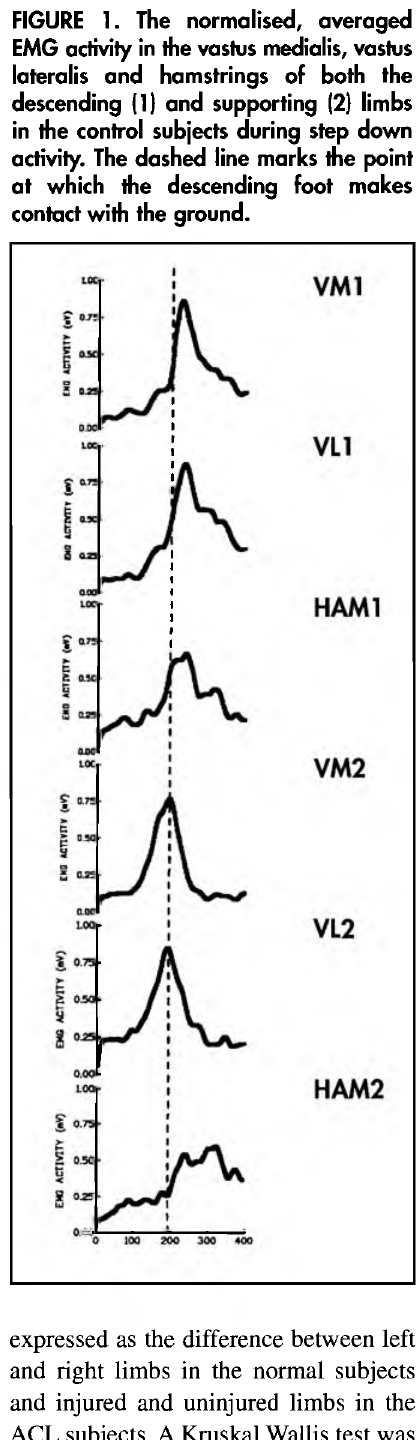
TABLE 1. Descriptive data of subjects in the control (CON); ACL deficient (ACLdef) and ACL reconstructed (ACLrec)